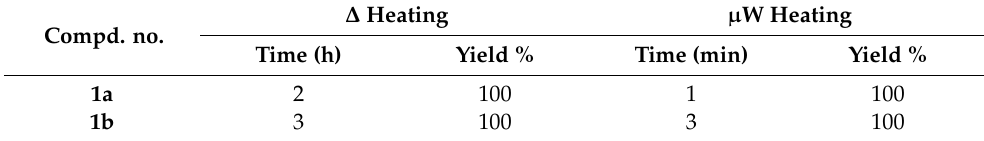
Table 3. Conventional and microwave-assisted reduction reaction of nitroaromatic compound. Compd. no.